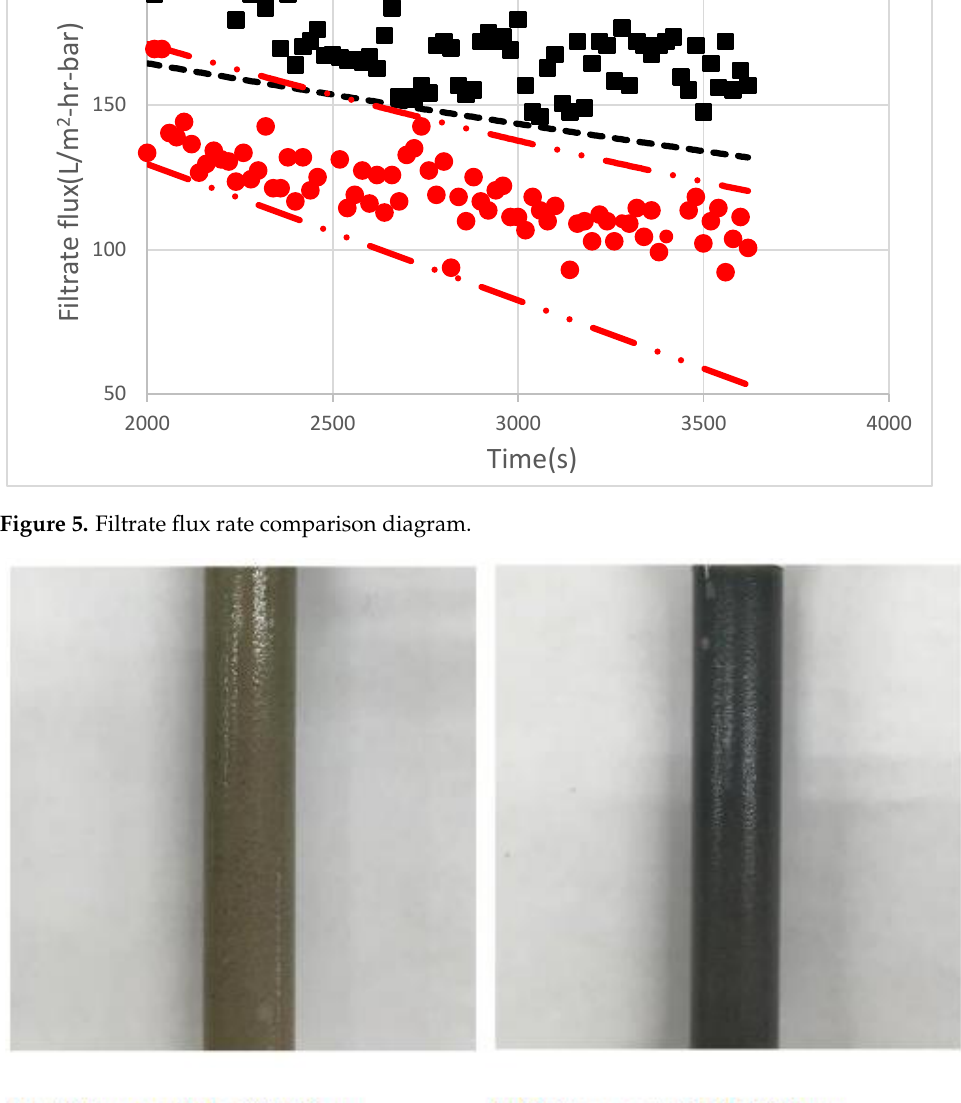
Figure 6. Exterior view of membrane fouling after experiment. (0.3 wt%, 2000 rpm). (a) silicon carbide 37~44 m; (b) silicon carbide 16~22 m